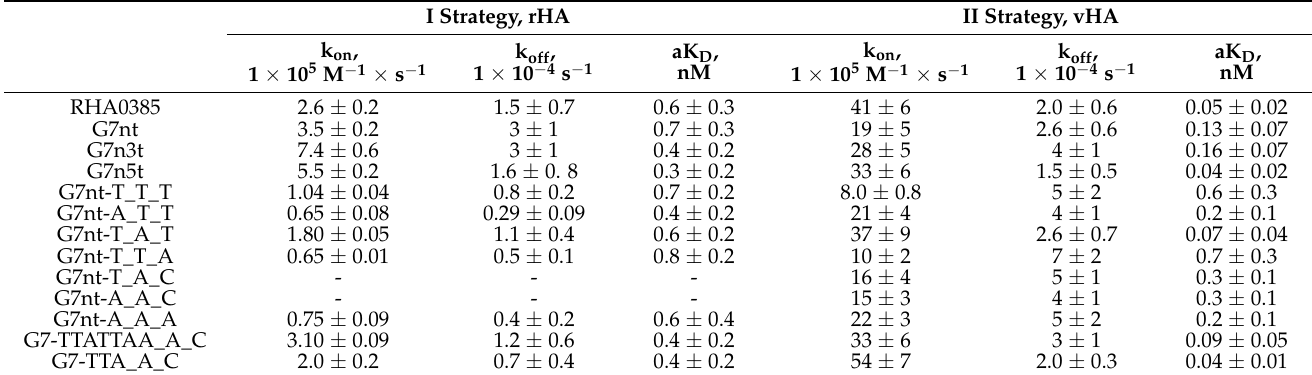
Table 2. The affinity parameters for RHA0385 and its variants complexed to vHA (A/chicken/Kurgan/3654at/2005 (H5N1)) and rHA (A/Vietnam/1203/2004 (H5N1)). The values of rate constants of association (k on , 1 × 10 5 M − 1 × s − 1 ) and dissociation (k off , 1 × 10 − 3 s − 1 ), and apparent dissociation constant (aK D , nM) are